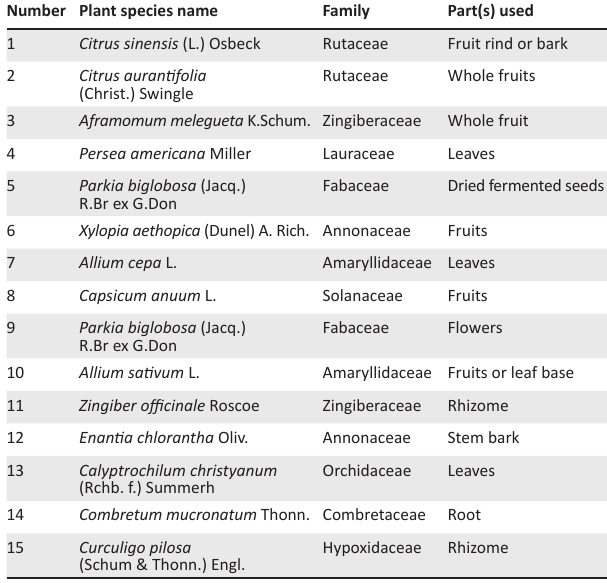
TABLE 6: Names of plants and their parts for the formulation of traditional oral powdered herbal formulations used as blood purifying or thinning drug in Ogbomoso, Nigeria.